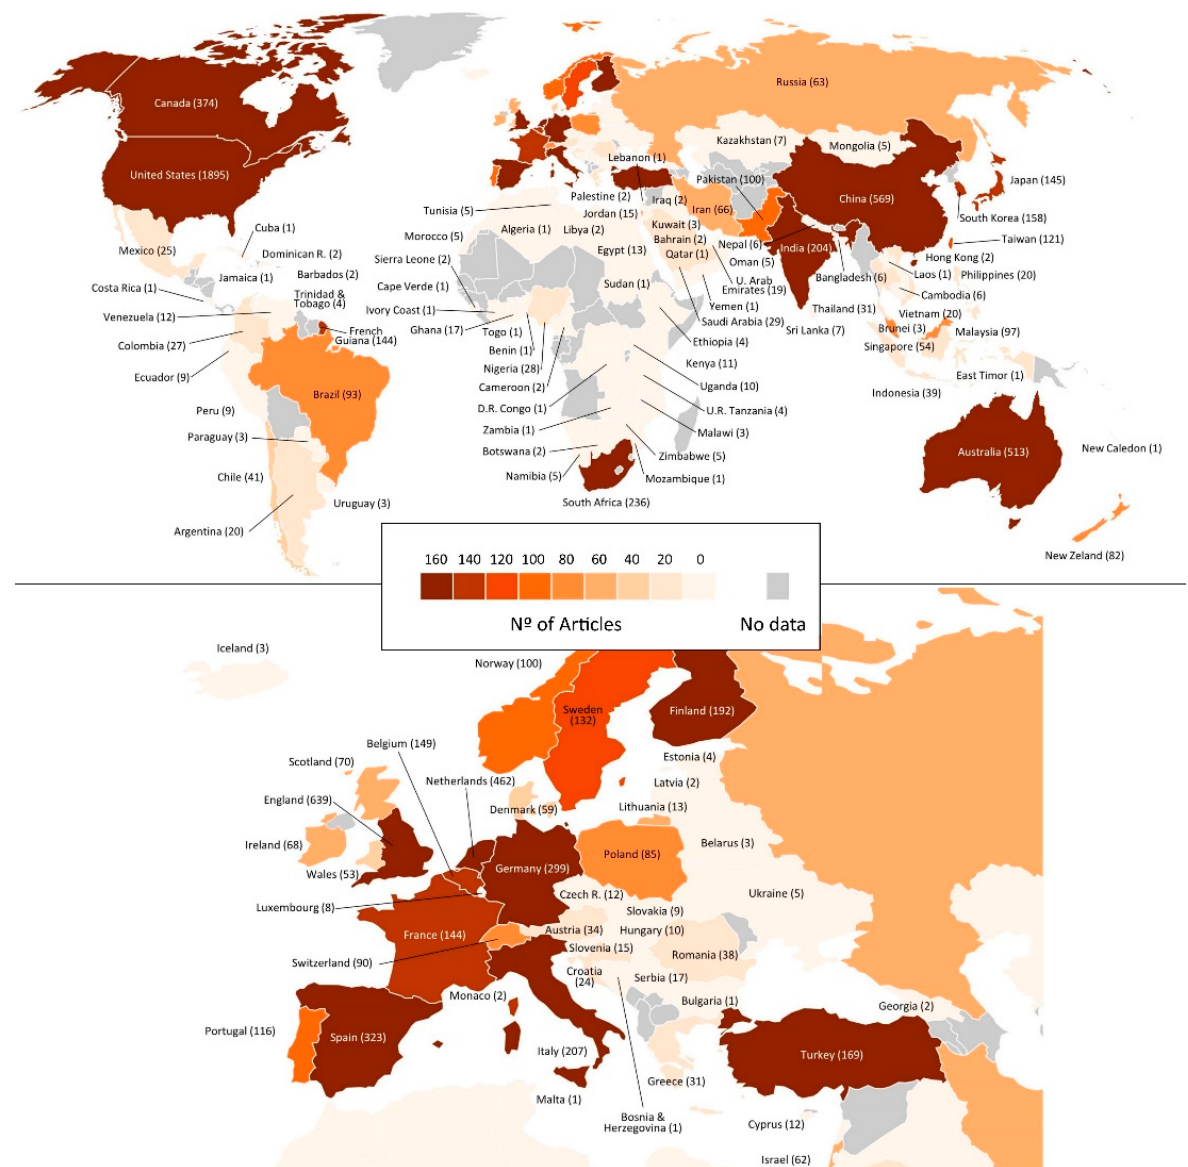
Figure 4. Geographical distribution of articles published in POP.